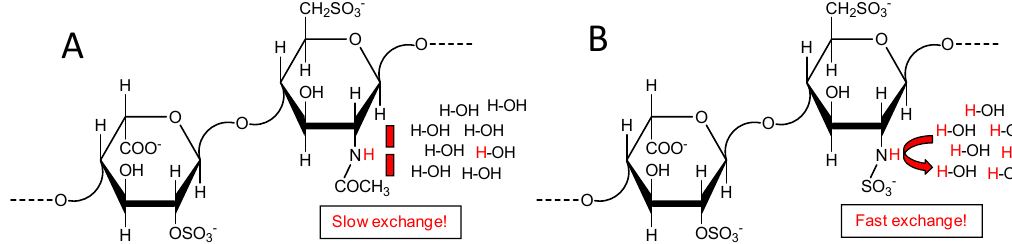
Figure 1. Structural representation of the main disaccharide building blocks of heparan sulfate [ → 4)- β - D -GlcA-(1 → 4)- α - D -GlcNAc-(1 → ] ( A ) and heparin [ → 4)- α - L -IdoA2S-(1 → 4)- α - D -GlcNS6S-(1 → ] ( B ). Although each unit can be seen in both GAG types, the first disaccharide is dominant in heparan sulfate while the second is more abundant in heparin. Structures highlight the different chemical exchange properties of the 15 N-linked protons of the N -acetyl and N -sulfated groups with the protons from the bulk solvent. Analysis on the scalar coupling multiplet pattern related to direct observation of 15 N in GlcNS is diagnostic of the chemical exchange regime of the amide proton.